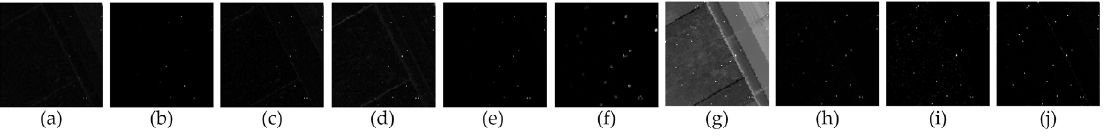
Figure 8. The detection results of different methods on the synthetic dataset: ( a ) RX; ( b ) LRX; ( c ) LSMAD; ( d ) LSDM–MoG; ( e ) CDASC; ( f ) 2S–GLRT; ( g ) BFAD; ( h ) SSFSCRD; ( i ) AED; ( j ) SCDF.